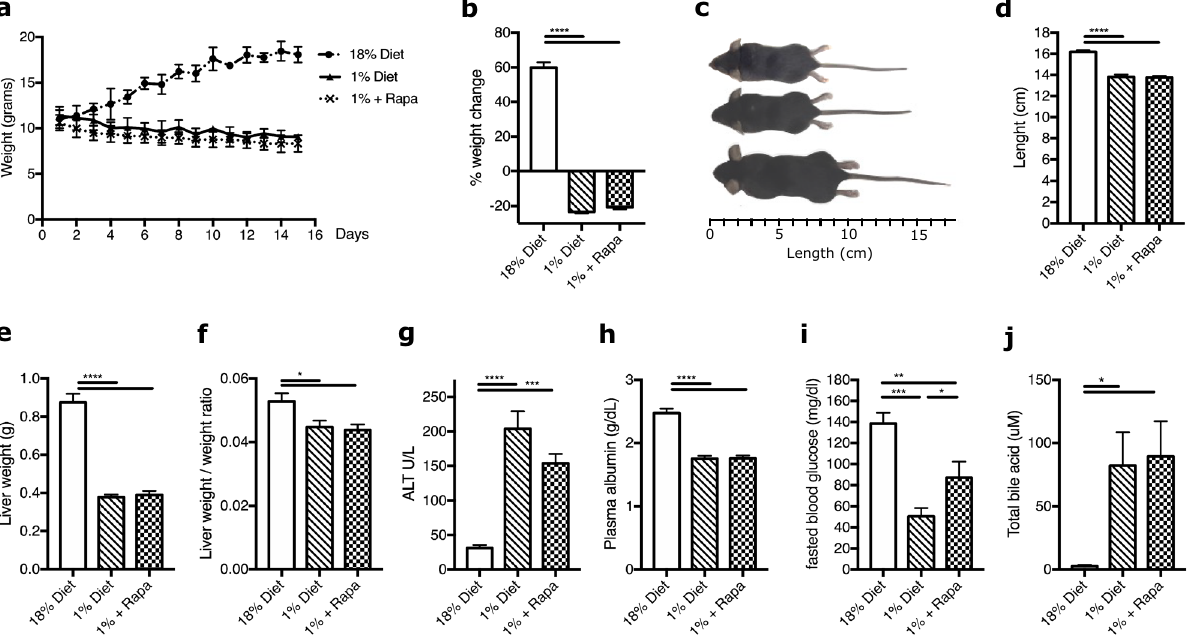
Figure 1. Low protein fed mice have altered morphometrics and liver function markers, with only fasting glucose levels improving by rapamycin. ( a ) Weight curve over 14 days, ( b ) Cumulative weigh change from weaning to sacrifice, %. ( c ) Photo of mice, from bottom 18% diet, 1% diet, 1% diet + Rapa. ( d ) Length at sacrifice, cm. ( e ) Liver weight (g). ( f ) Liver weight/body weight ratio. ( g ) ALT, U/L. ( h ) Plasma albumin, g/dl. ( i